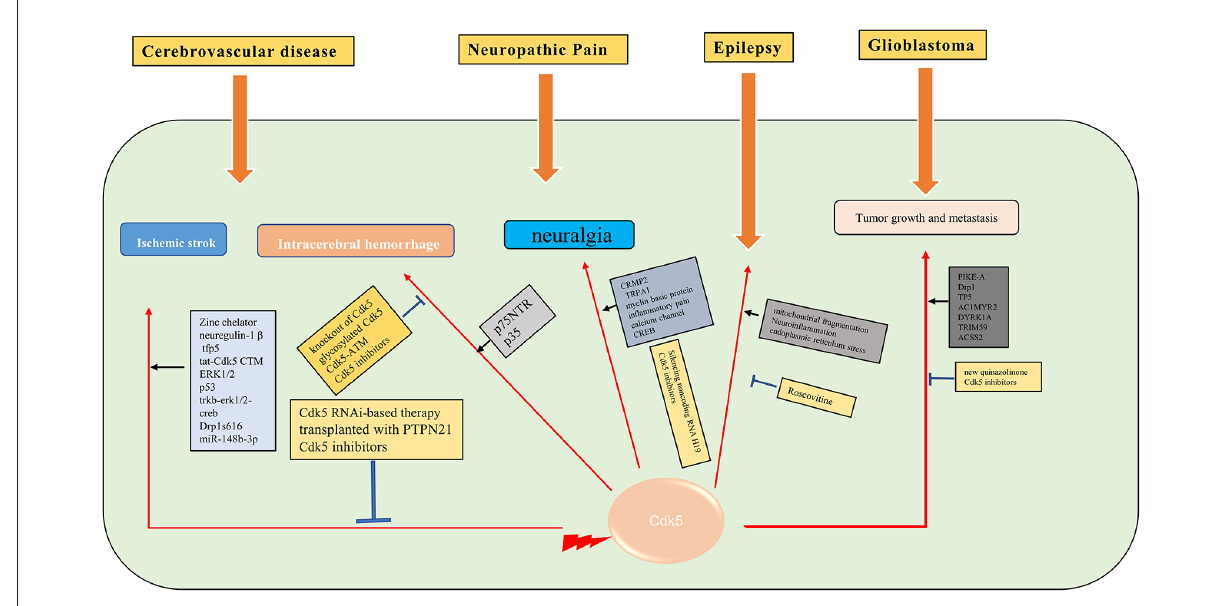
FIGURE3 Molecular mechanisms of Cdk5 in some of the neurological diseases. → : promote or aggravate; (cid:97) : inhibit or